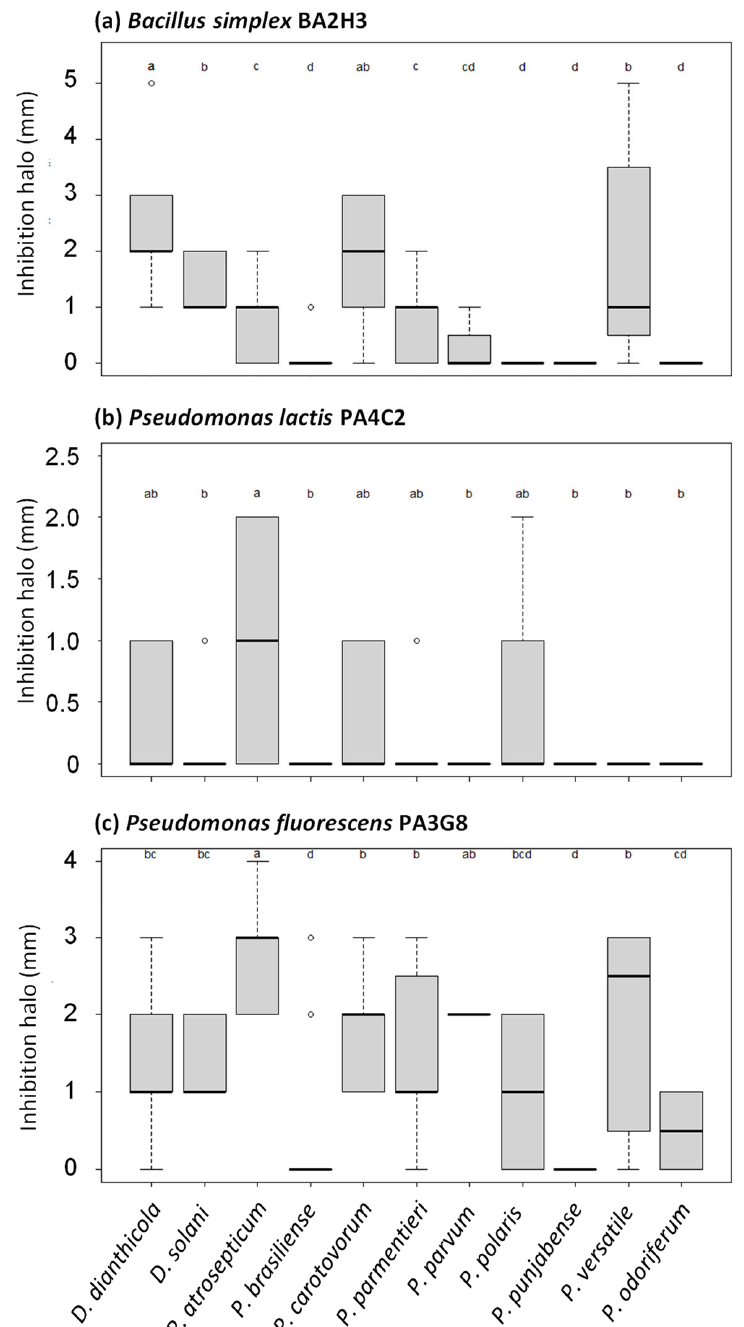
Figure 5. Refined analysis of growth inhibition halos caused by B. simplex BA2H3 ( a ), P. lactis PA4C2 ( b ) and P. fluorescens PA3G8 ( c ). The same data shown in Figure 3 were analyzed in a different way. For each biocontrol agent, we calculated mean value and variation for all halos collected with pathogen isolates belonging to the same species. Statistical differences (Kruskal–Wallis test multiple comparison (Dunn), p -value adjusted with the Benjamini–Hochberg method, alpha = 0.05) are indicated by different letters (a to d); horizontal bar indicates mean value.